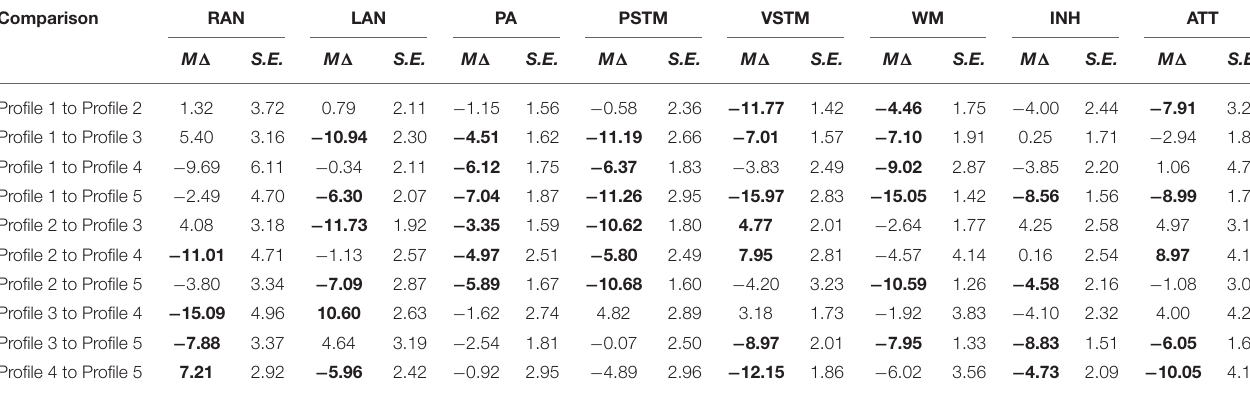
TABLE 5 | Mean differences and standard errors between the latent profiles in the cognitive functioning measures. Comparison